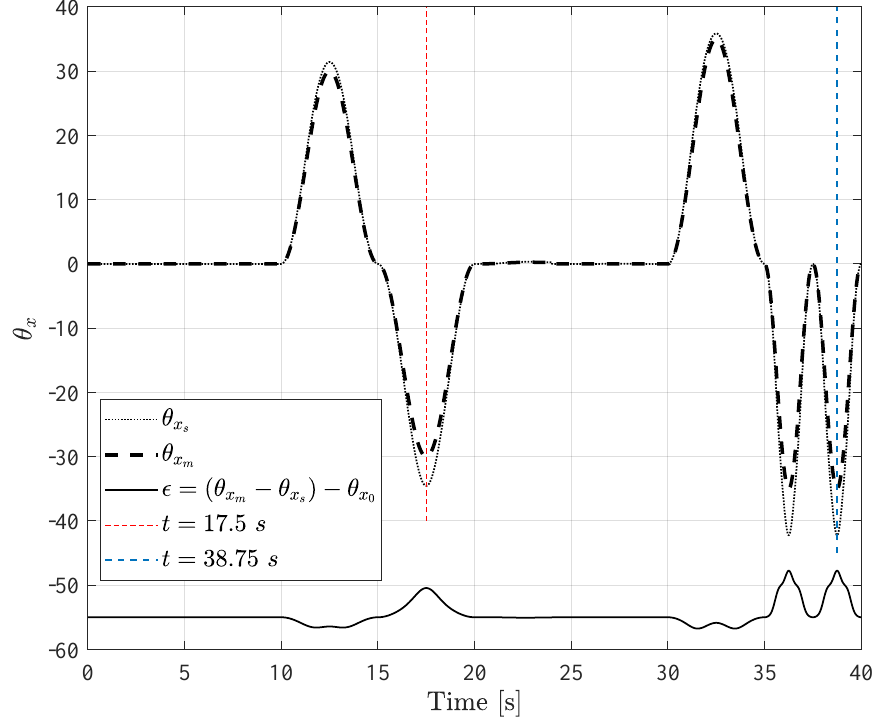
Figure 10. Master to slave R x